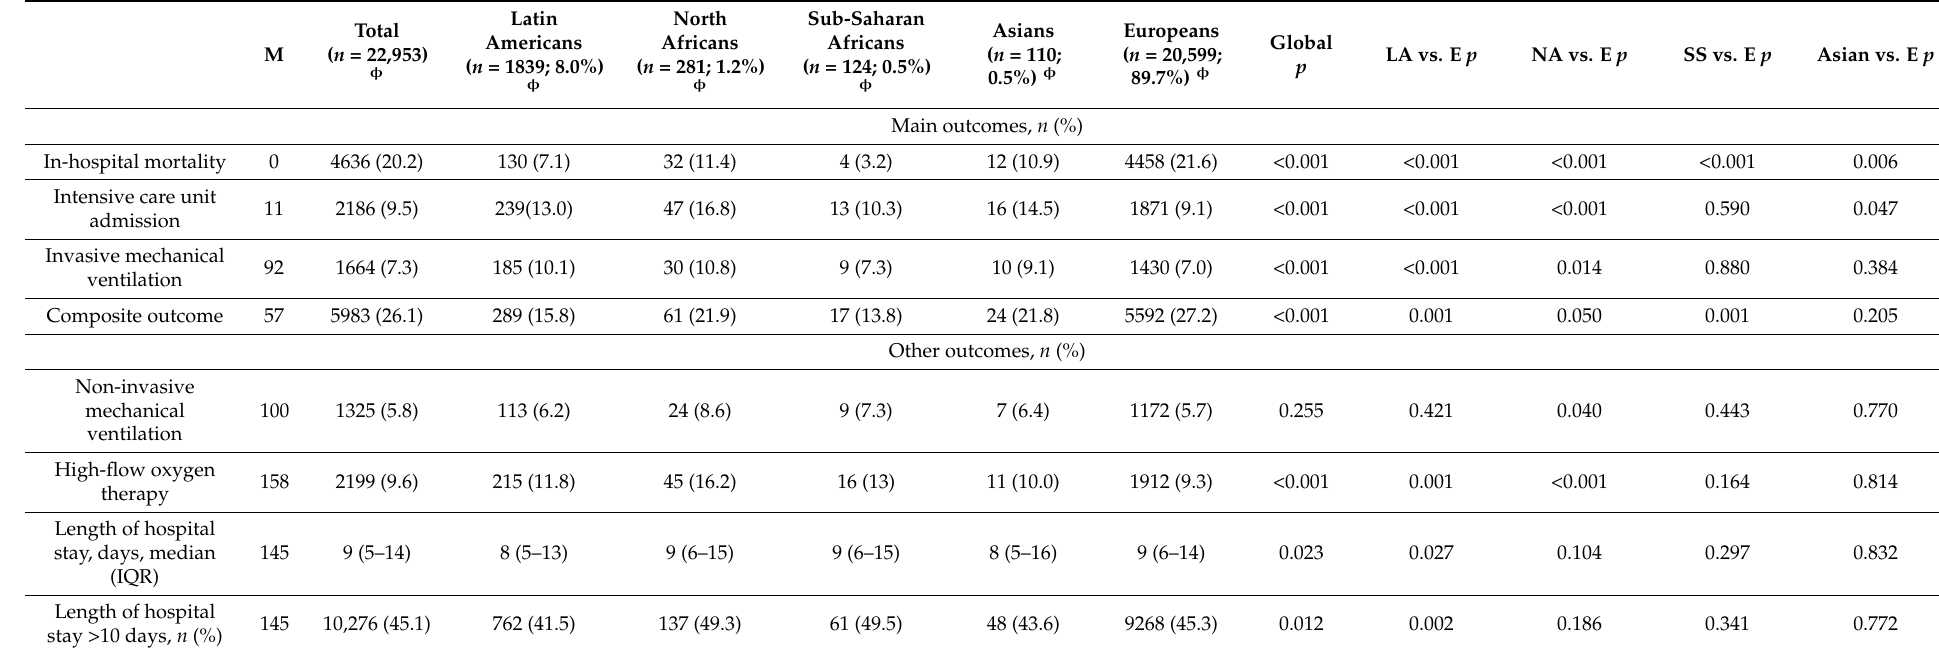
Table 2. Outcomes of patients with confirmed COVID-19 by ethnic